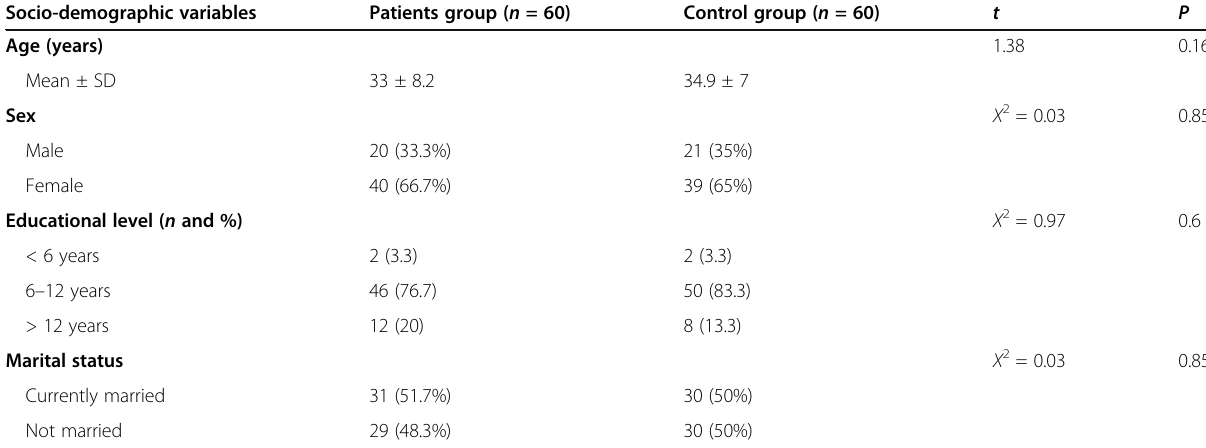
Table 1 Socio-demographic variables